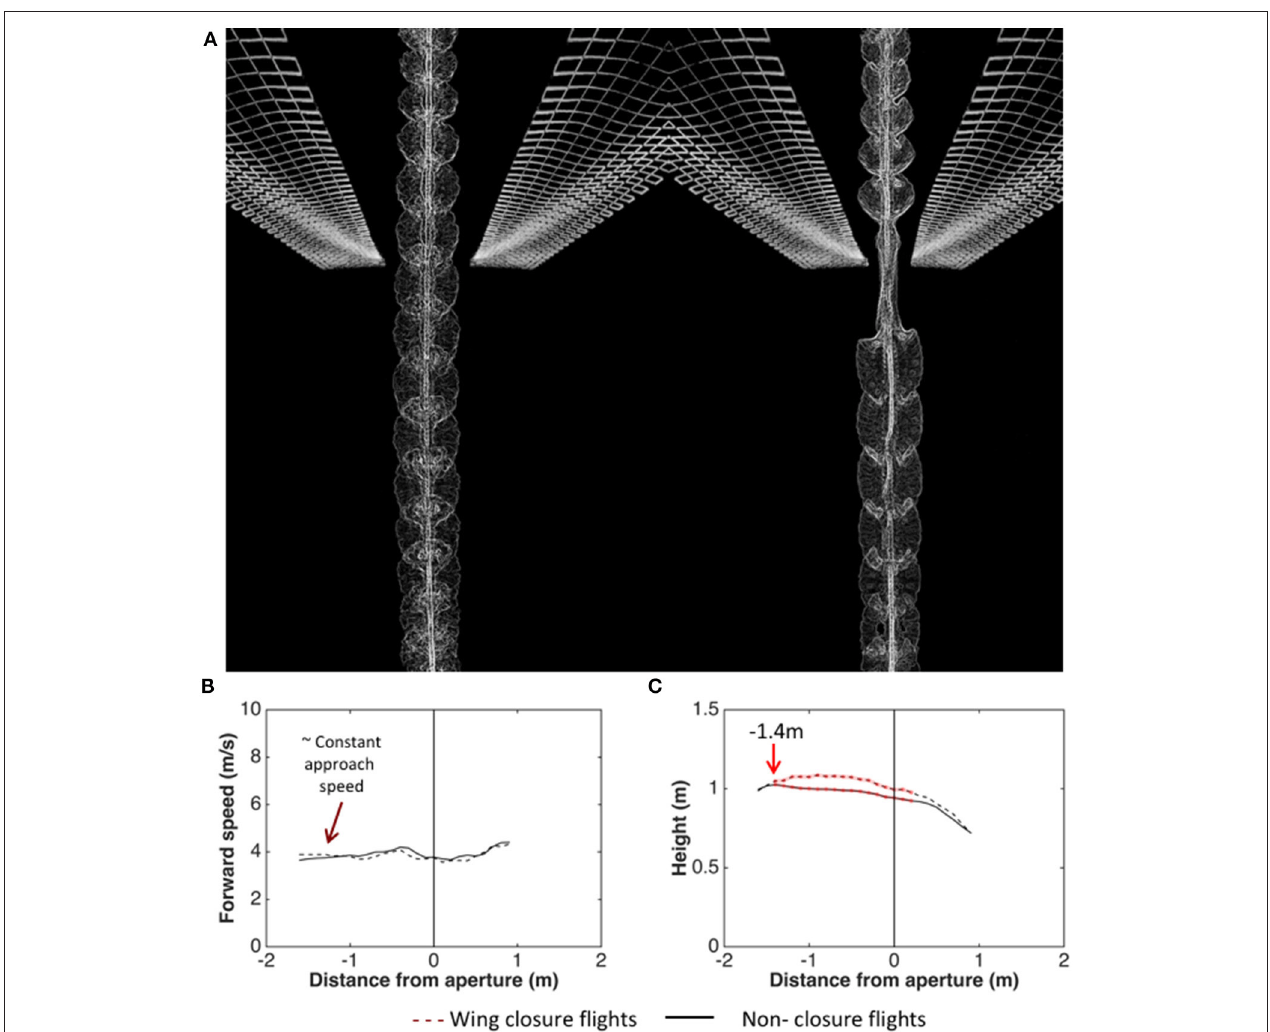
FIGURE 5 | (A) Video-based visualization of Budgerigar flight through an aperture that is wider than the wingspan (left) and narrower than the wingspan (right). Image courtesy H. Vo and I. Schiffner. (B,C) Analysis of trajectories of Budgerigars approaching apertures of various widths, comparing flights through apertures that require wing closure (dashed curves) with flights through apertures that do not require wing closure (solid curves). Left: Mean profiles of flight speed; Right: Mean profiles of height. Adapted from Vo et al.